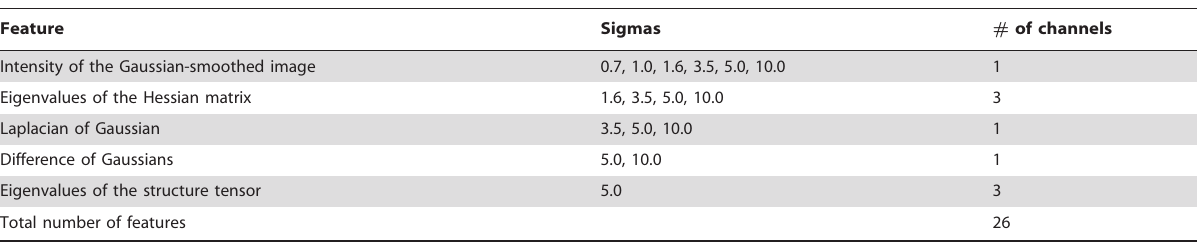
Table 1. Pixel features.